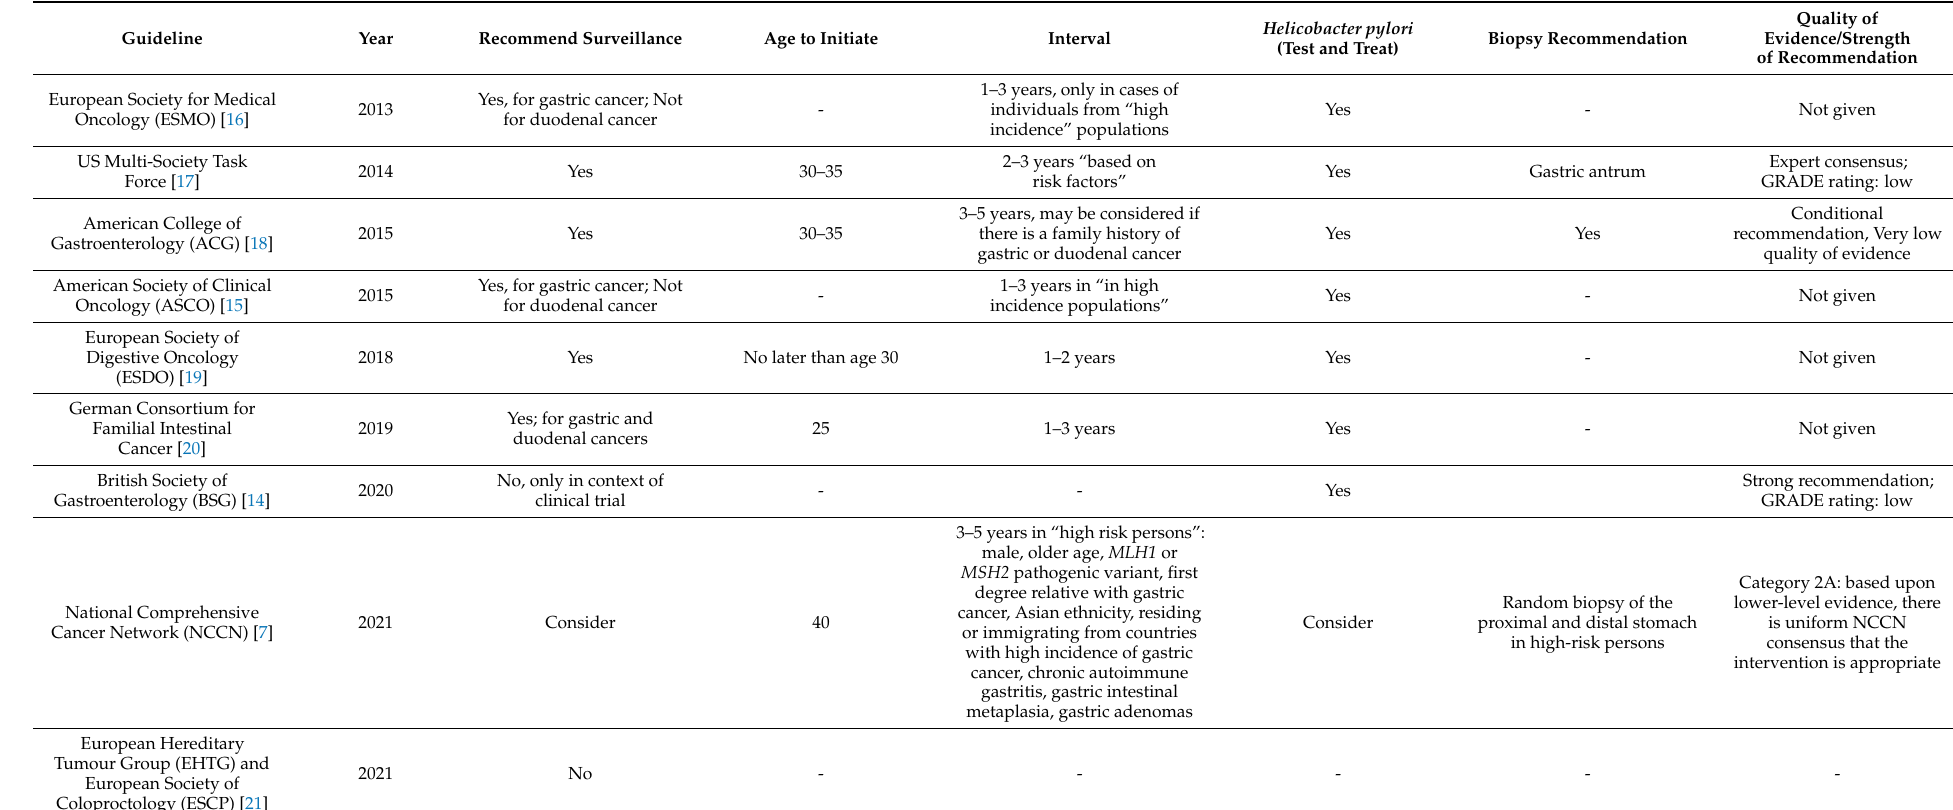
Table 1. Summary of current guidelines addressing UGI cancer surveillance in Lynch